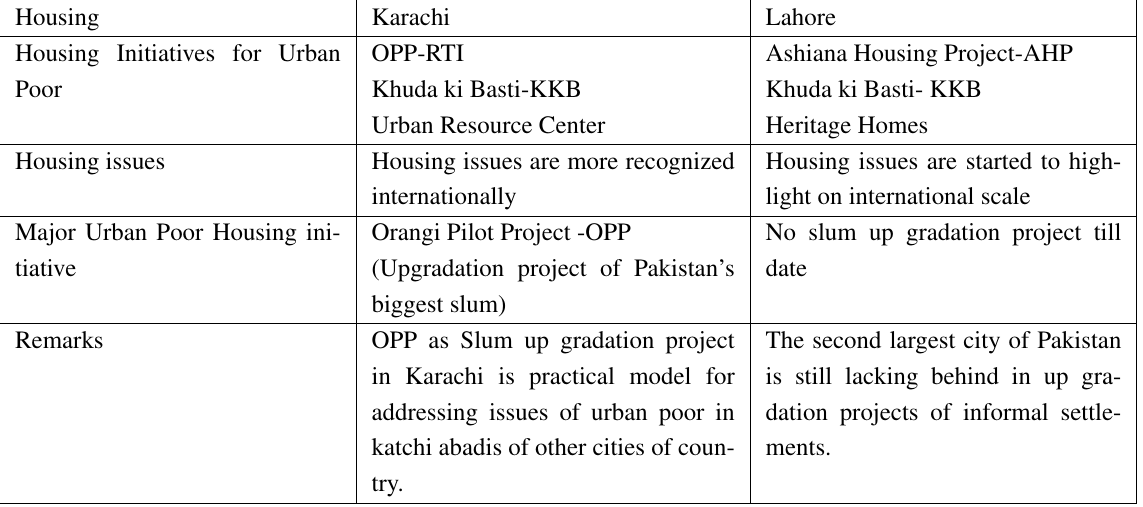
Table 1. A comparison of housing intiatives for Karachi and Lahore,